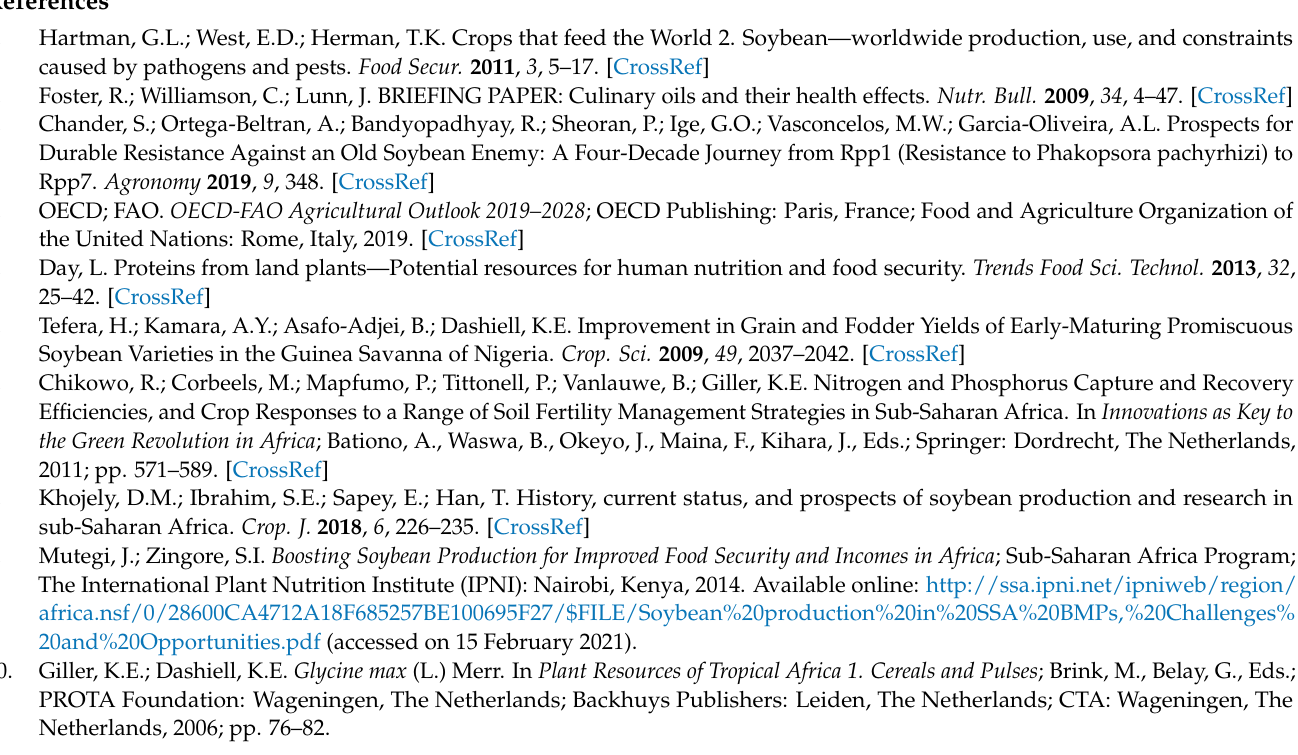
Table S3: Population structure analysis by NJ, STRUCTURE and